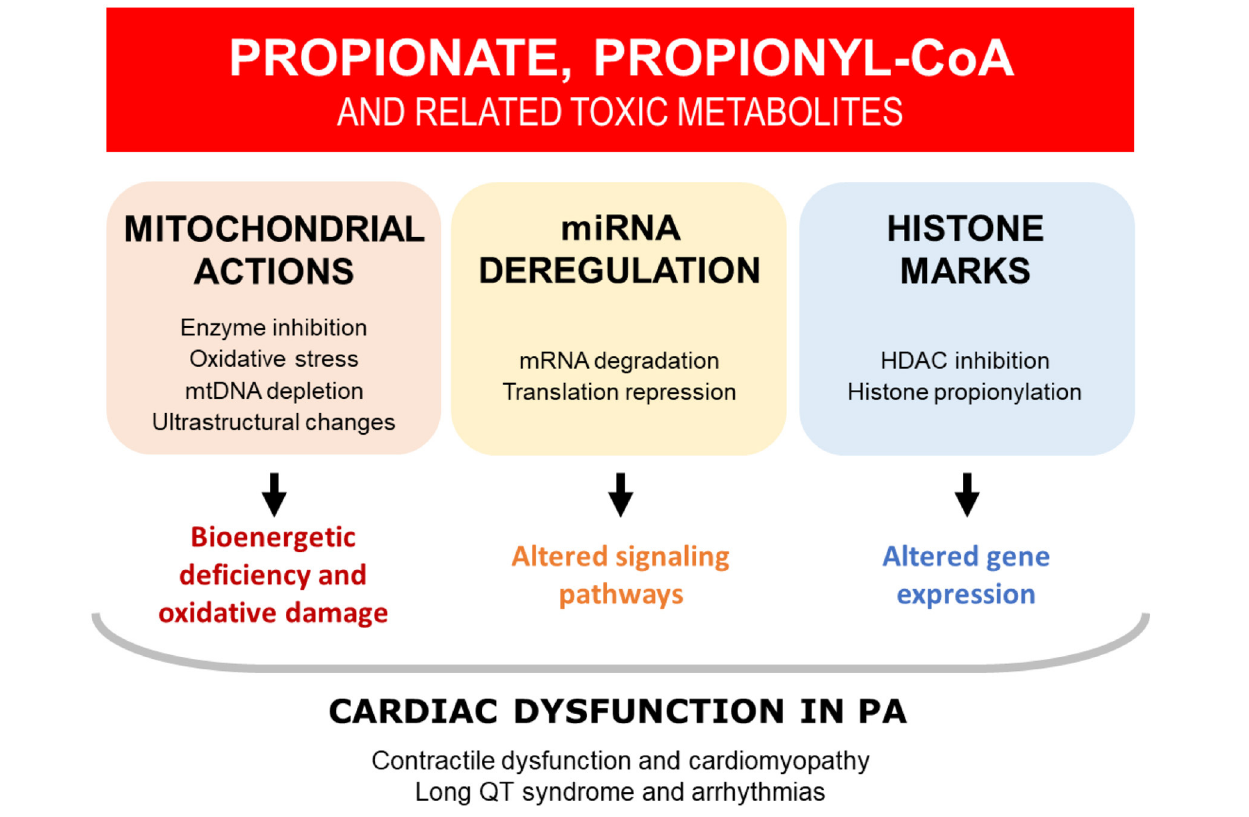
FIGURE 3 | Overview of the potential mechanisms that may contribute to cardiac dysfunction in PA. The available evidence suggests that cardiac dysfunction in PA is driven by the toxic accumulation of metabolites, secondary to defective propionyl-CoA carboxylase (PCC). Multiple mechanisms have been identified, which are likely to be interrelated and acting in tandem. HDAC, histone deacetylase; miRNA, microRNA; mtDNA, mitochondrial DNA; PA, propionic